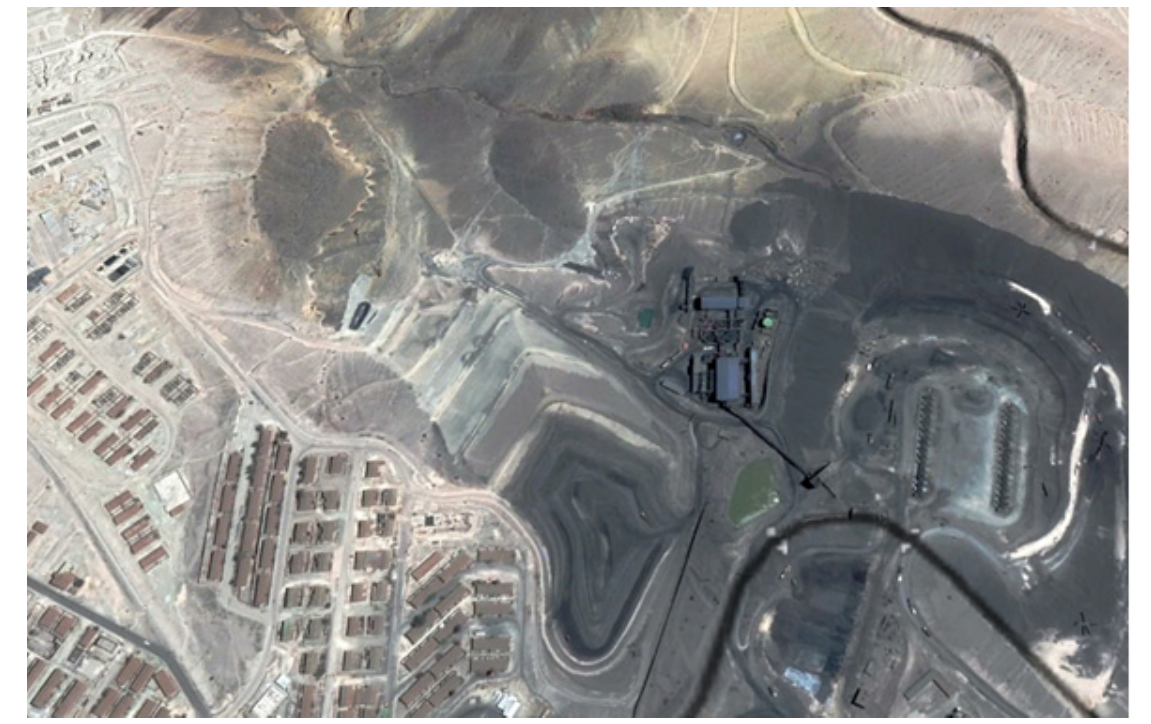
Figure 54. Potrerillos Copper Slag Treatment Plant and Filtered Tailings Storage Facility [18,69].